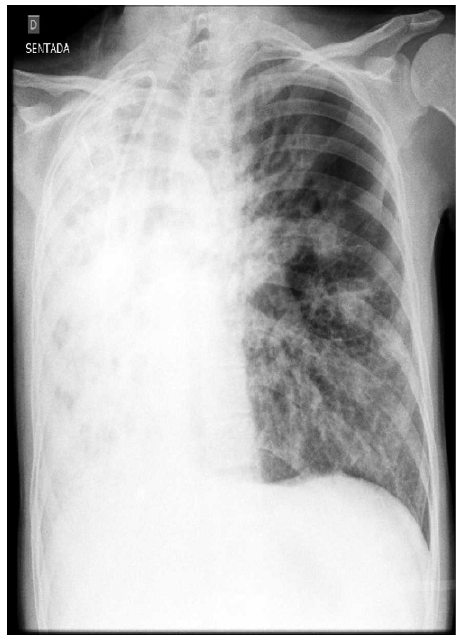
Figure 1 - Chest X-ray showing a diffuse opacity of the right lung that is compatible with atelectasis.